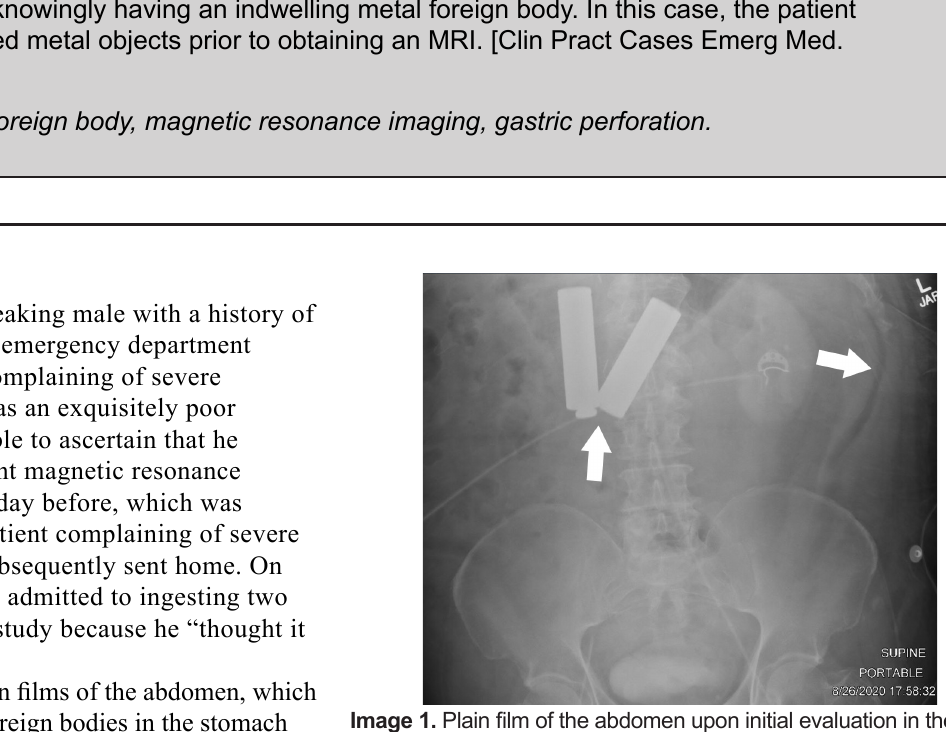
Image 1. Plain film of the abdomen upon initial evaluation in the emergency department to indicate position of foreign bodies, approximately one day after the patient received magnetic resonance imaging (MRI). Left arrow indicates foreign bodies within the stomach, which were reported to be two AA batteries per the patient, ingested prior to the MRI study. Right arrow indicates free air within the abdomen suggesting hollow viscus